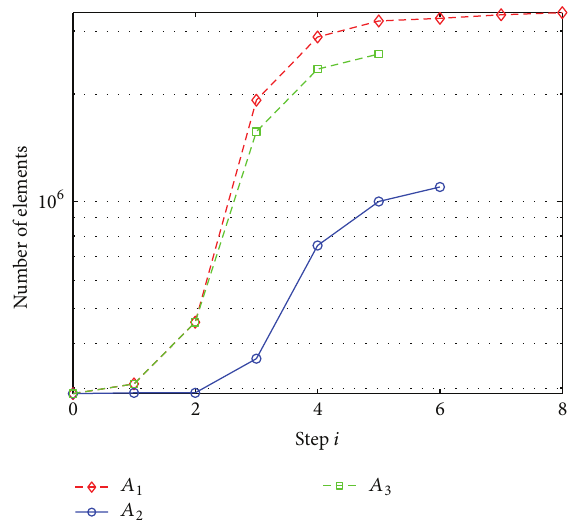
Figure 6: Evolution of the number of elements with strategies 𝐴 1 , 𝐴 2 , and 𝐴 3